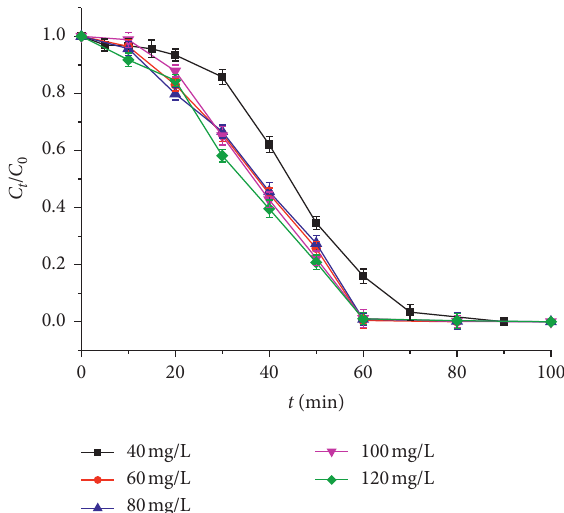
Figure 11: MO decomposition profile by heterogeneous UV/H Fenton-like process using the MIL-53 catalyst at different initial MO concentrations (experimental conditions: 0.5g/L of the cat- alyst; 0.192M · H 2 O 2 ; temperature 30 ° C; UV radiation).